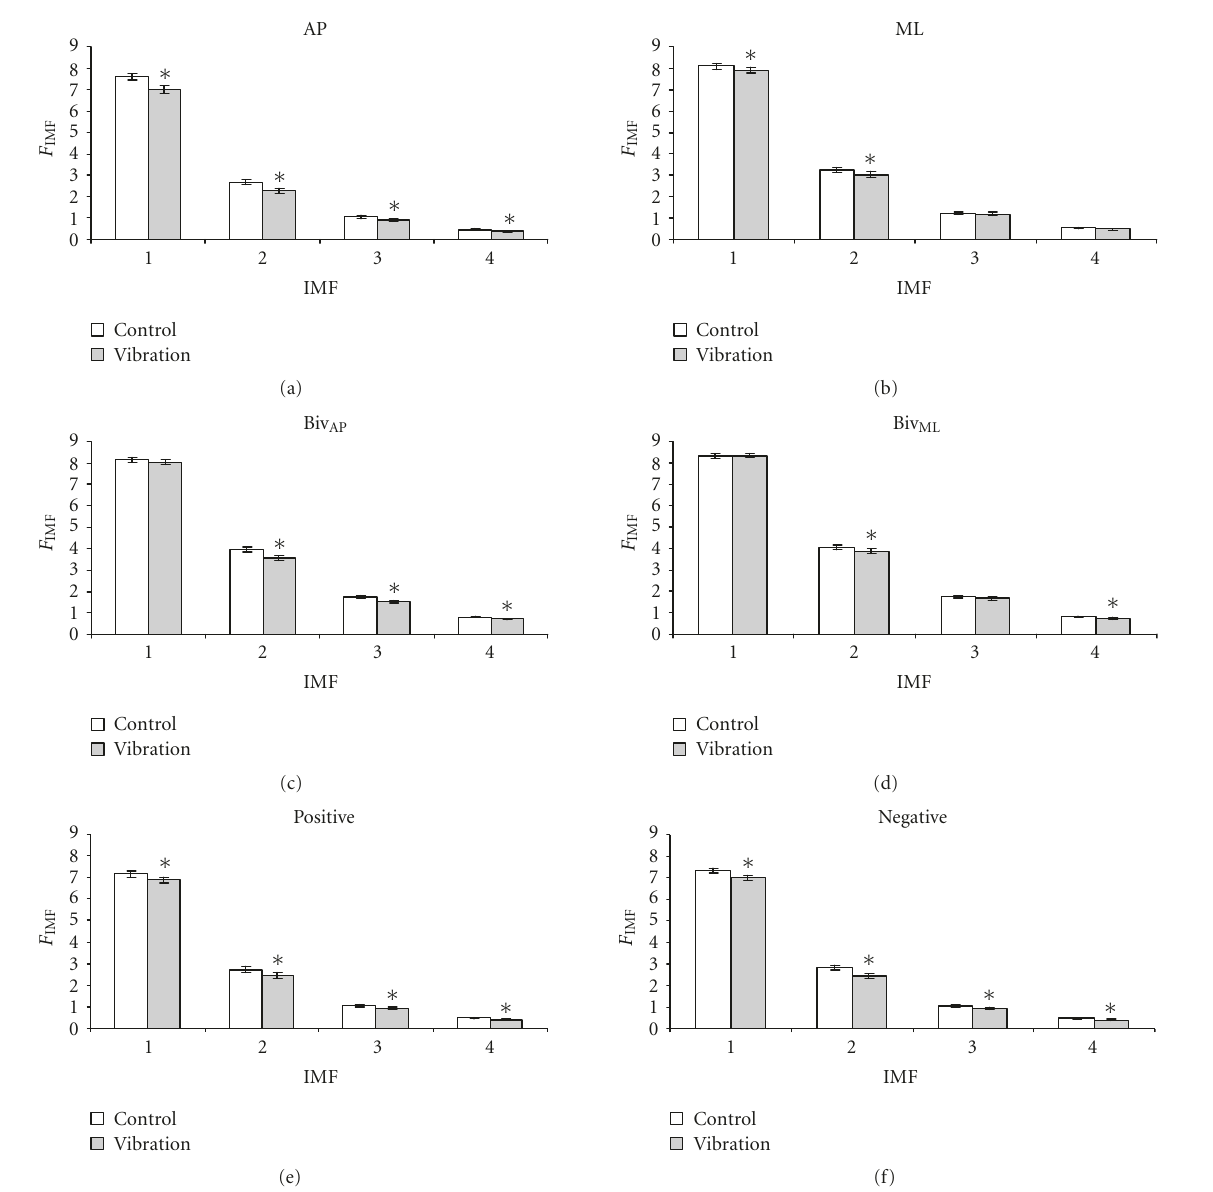
Figure 7: The average rotation frequency ( F IMF ) of the first four IMF for control and vibration subjects. (a) EMD for AP displacement; (b) EMD for ML displacement; (c) bivariate-EMD for the imaginary part of the signal (corresponding to AP displacement); (d) bivariate-EMD for the real part of the signal (ML); (e) complex-EMD for positive components; and (f) complex-EMD for negative components. Data are mean and 95% confidence intervals. ∗ Significant di ff erence from control